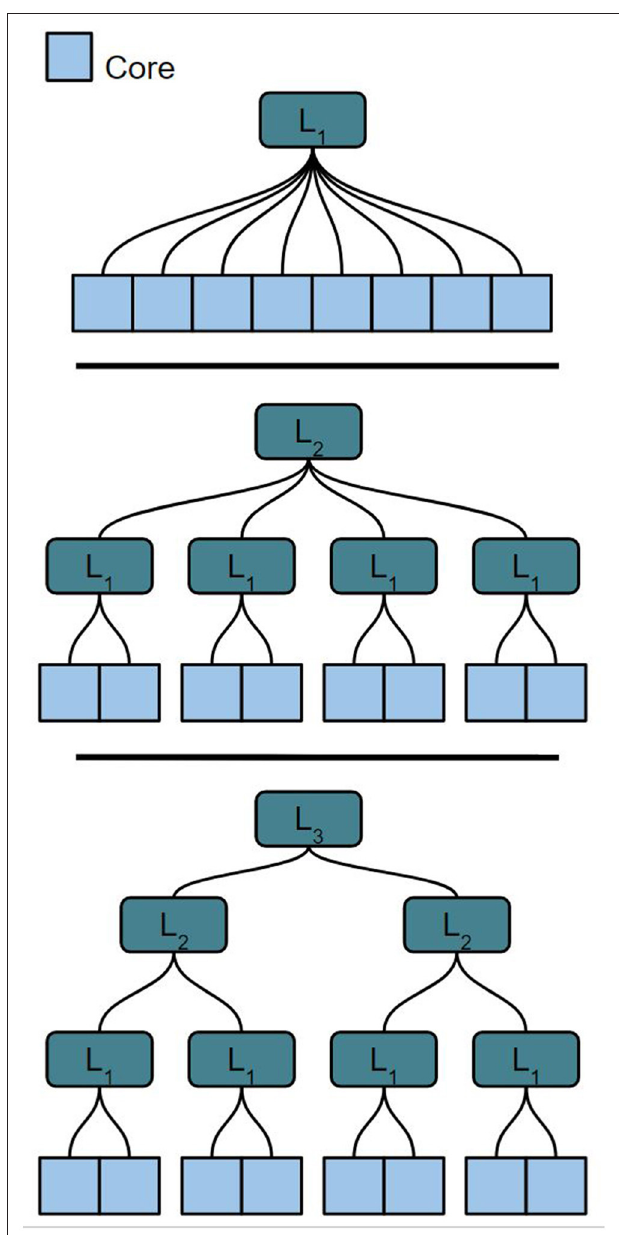
FIGURE 1 | Different potential tree-based HiAER network configurations for 8 cores with varying L i and a fixed core count K